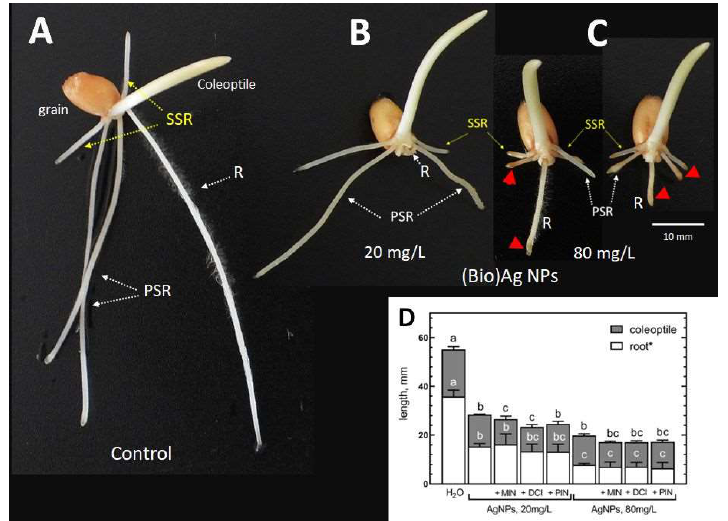
Figure 1. The morphology of 3-day-old seedlings of wheat ( Triticum aestivum L. cv. Ostka Strzelecka) developing in the absence ( A ) or presence of (Bio)Ag NPs (at ( B ) 20 or ( C ) 80 mg/L). The browning root tips are indicated by red arrows. Abbreviations: R—radicle, PSR—primary seminal roots, SSR—secondary seminal roots. The inhibition of seedling growth (elongation of radicle and coleoptile) by (Bio)Ag NPs alone (at 20 and 80 mg/L) and in mixtures with cyclitols (+MIN, +DCI, +PIN) is shown in ( D ) (values are means ( n = 3) + SD, and bars with the same letters (a–c) were not significantly ( p < 0.05) different after ANOVA test and Tukey’s post hoc corrections).